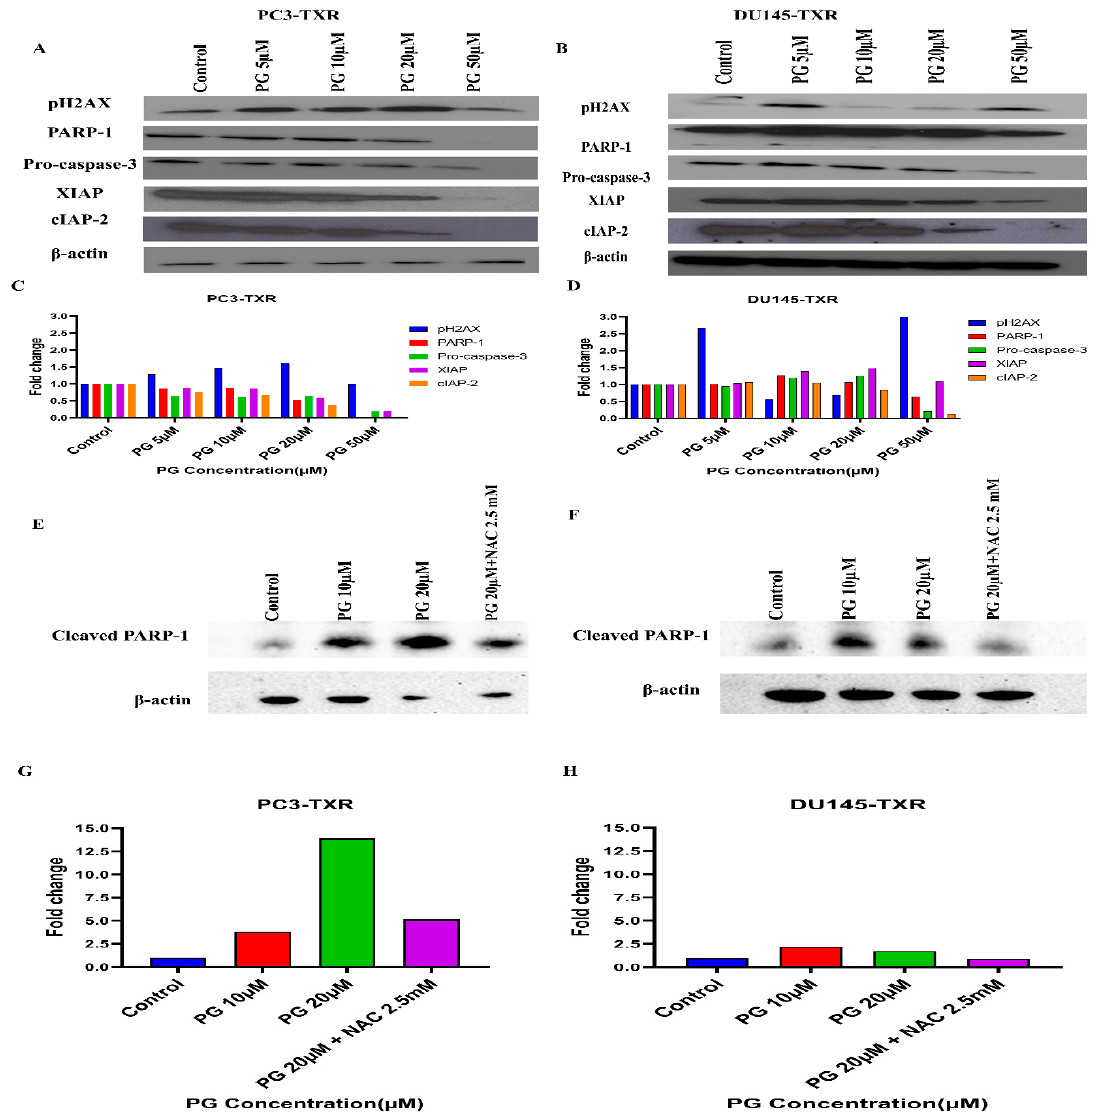
Figure 13. PG differentially modulates the expression of key apoptotic markers and DNA damage markers in taxane-resistant PCa cell lines. ( A ) PC3-TXR and ( B ) DU145-TXR cells were treated with varying concentrations of PG, and an immunoblot assay was performed. PG induces downregulation of various apoptotic markers, such as pro-caspase-3, XIAP, and cIAP-2. We also observed that the DNA damage marker pH2AX is upregulated, and PARP-1 is downregulated. ( C ) and ( D ) represent the quantified results of relative band intensities calculated using ImageJ, and relative expression levels were plotted against PG treatment. ( E ) and ( F ) depict the expression of cleaved PARP-1 in PC3-TXR and DU145-TXR, respectively, confirming that PG induces taxane-resistant PCa cell lines to commit apoptosis. ( G ) and ( H ) are graphical representations of the relative band intensities calculated using ImageJ, and fold change in expression levels were plotted against various PG treatments.